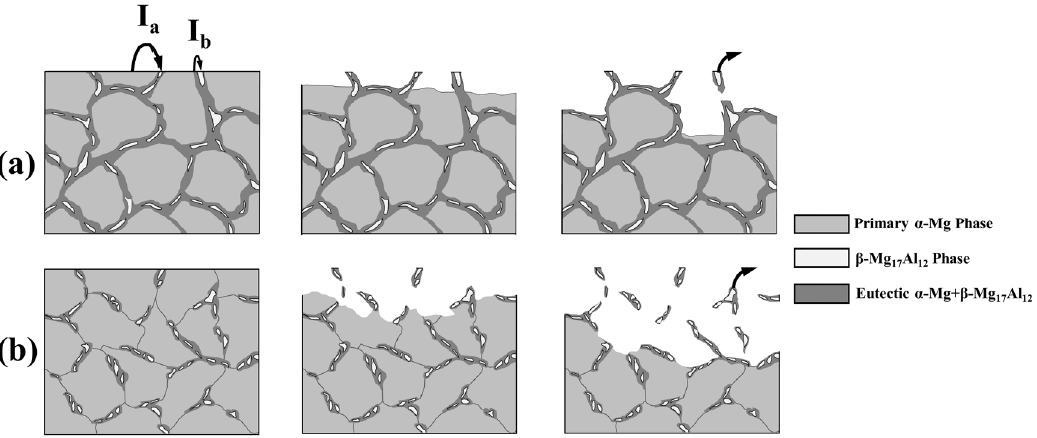
Figure 7. Schematic diagram of corrosion behavior in ( a ) HPDCed sample and ( b ) GCed alloys.